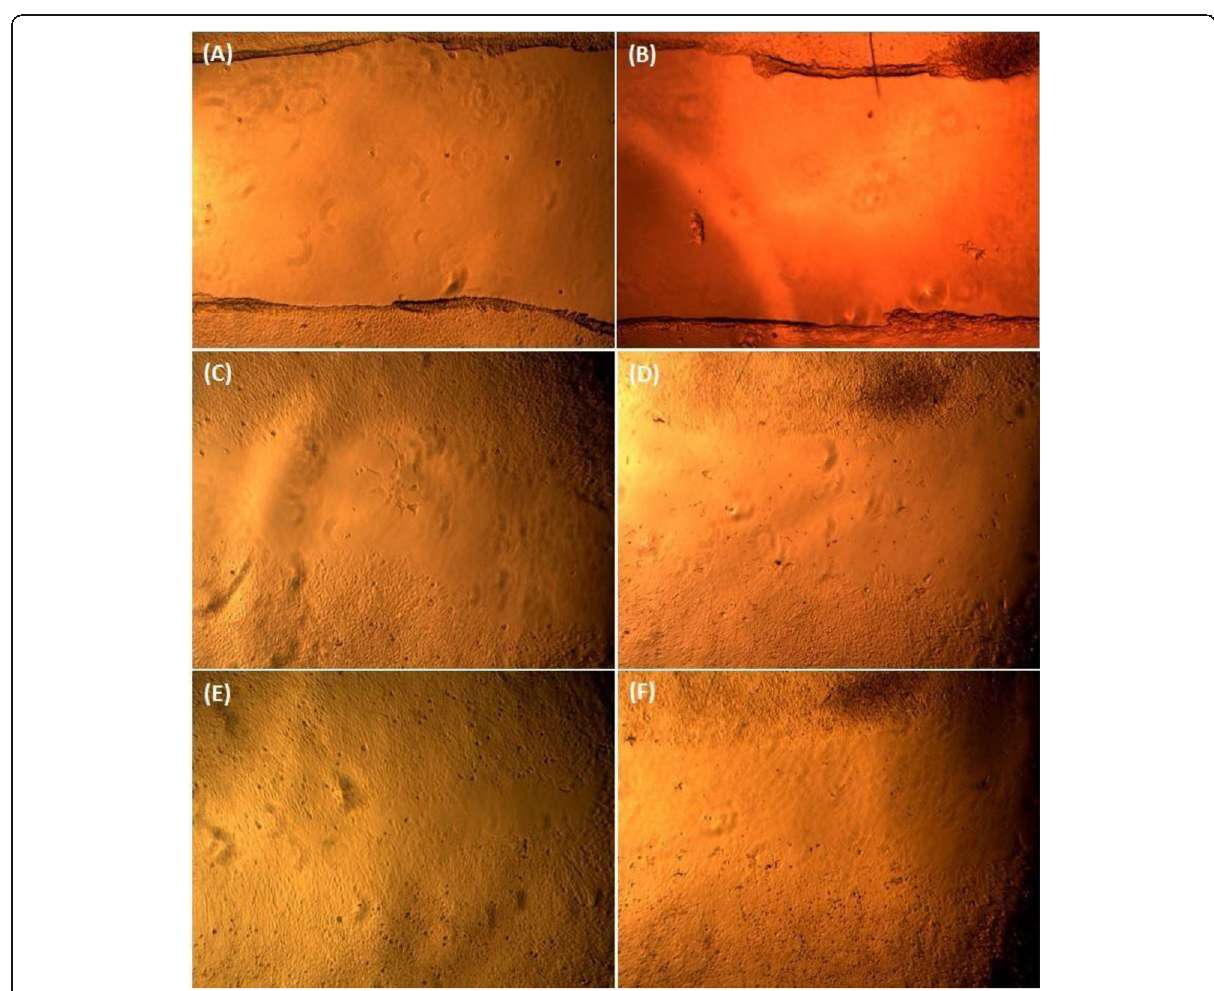
Fig. 4 Phase contrast microscopic images of PA 1 cells after 0th hour of incubation. A Control, B treated 24th hours of incubation, C control, D treated 48th hours of incubation, E control, F